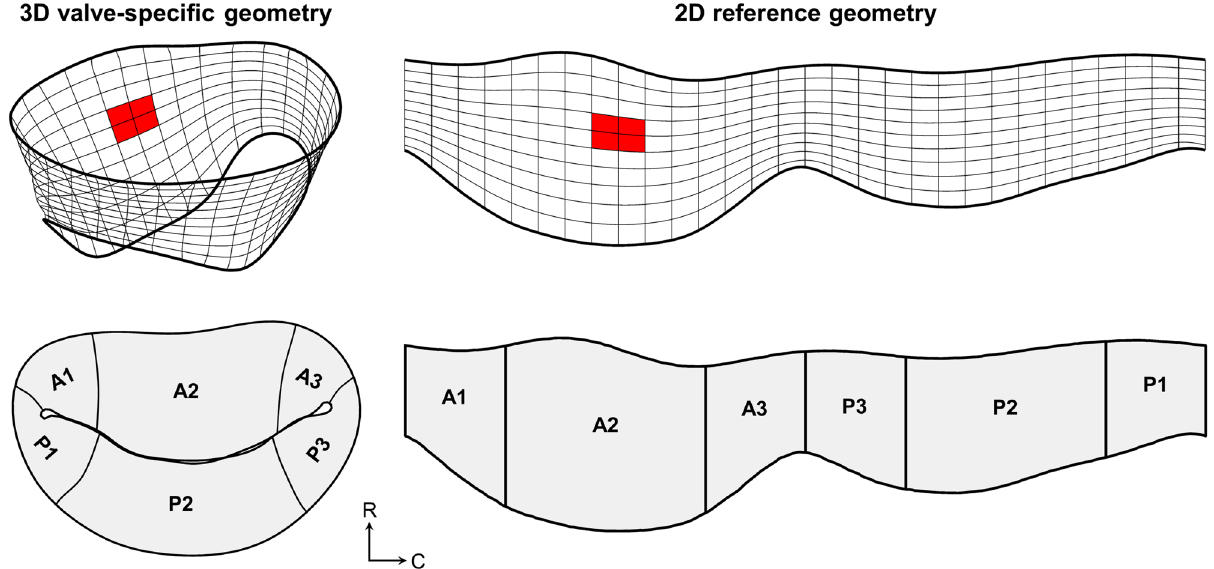
Figure 13. A representative MV, parameterised using a conformal map to allow for precise inter-subject registration of local leaflet attributes (e.g. directional stretches) as well as systematic definition of Carpentier leaflet segments. The parameterised 3D surface can be naturally unfolded onto a 2D domain for visualisation of attributes in otherwise obscured regions of the leaflet (see Supplementary Information for stretch field results in